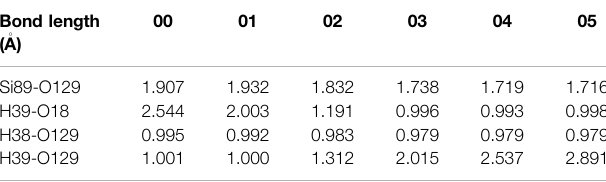
TABLE 3 | Changes in bond length for the reaction of H 2 O and P b0 defect. Bond length ( (cid:1)